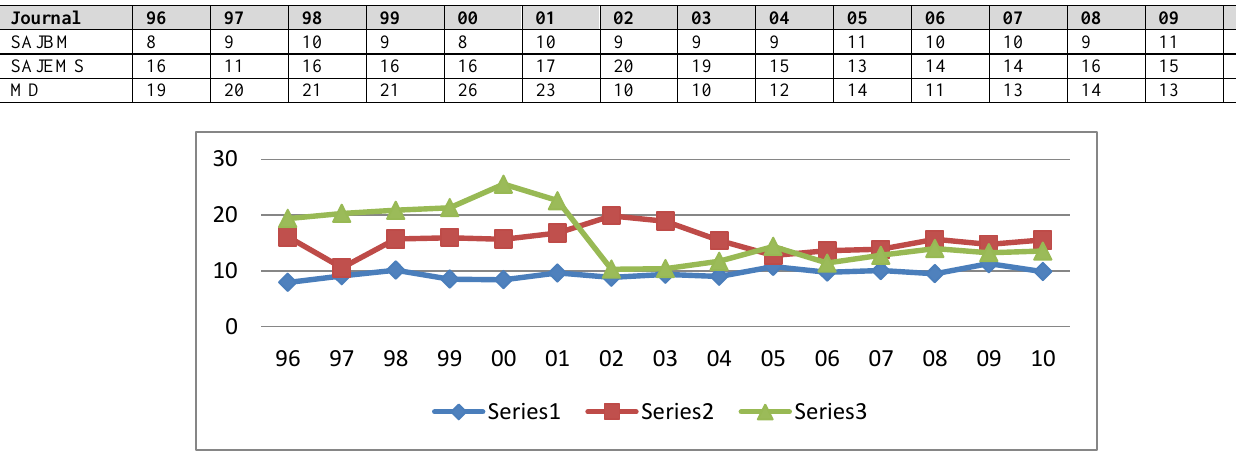
Figure 1: Page lengths of all three journals over the past fifteen